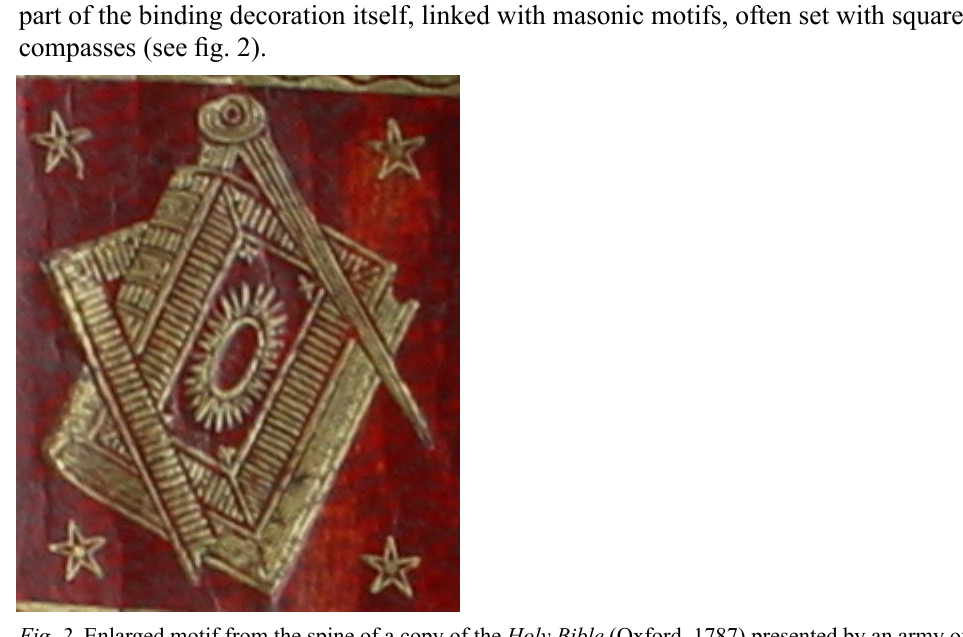
Fig. 2. Enlarged motif from the spine of a copy of the Holy Bible (Oxford, 1787) presented by an army officer, William Mourgue, to his lodge. Copyright and reproduced by permission of the Museum of Freemasonry, London.